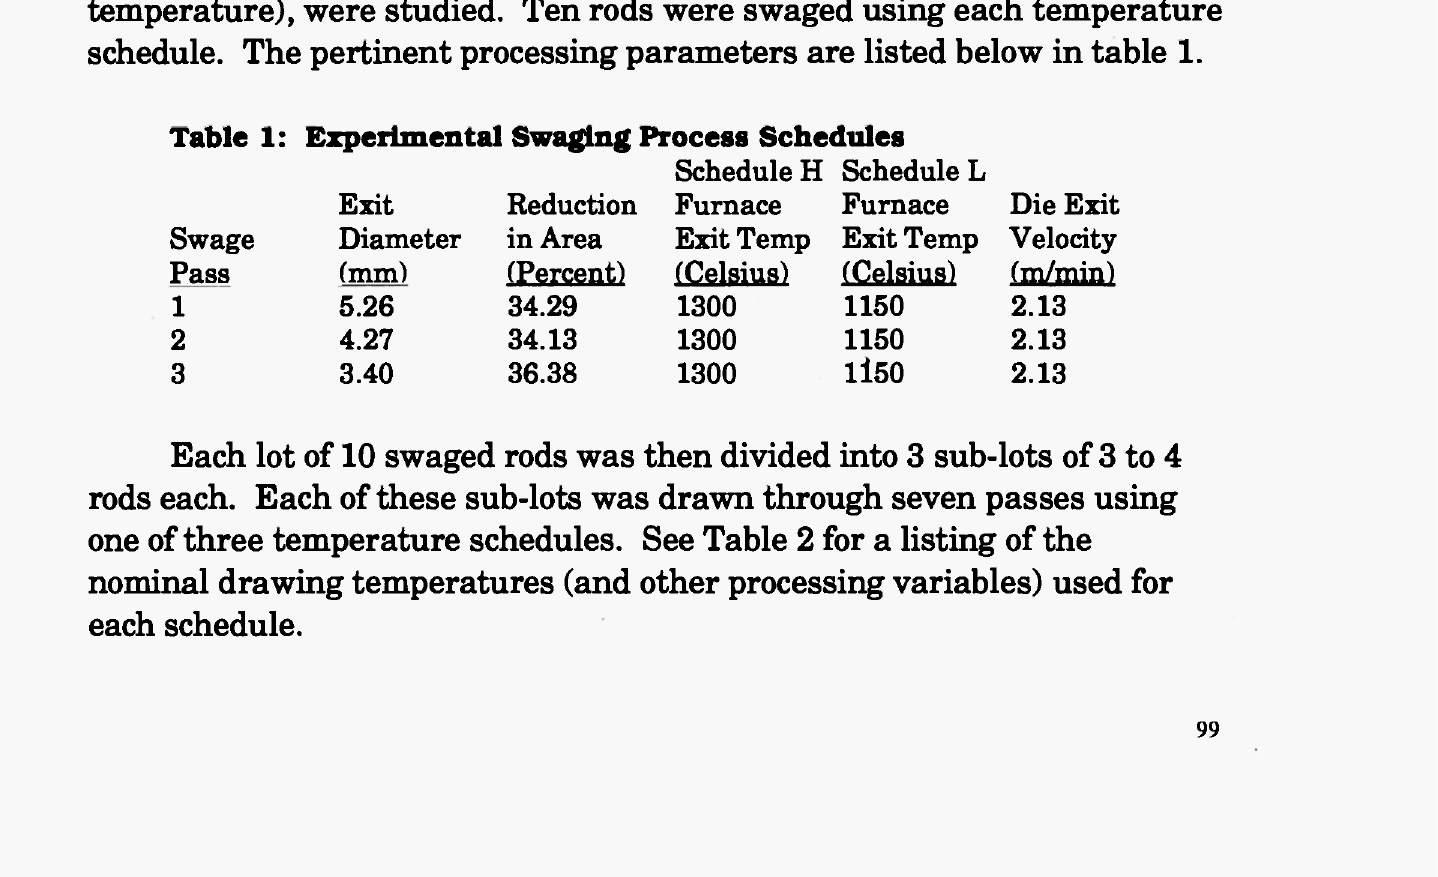
Table 1: Experimental Swaging Process